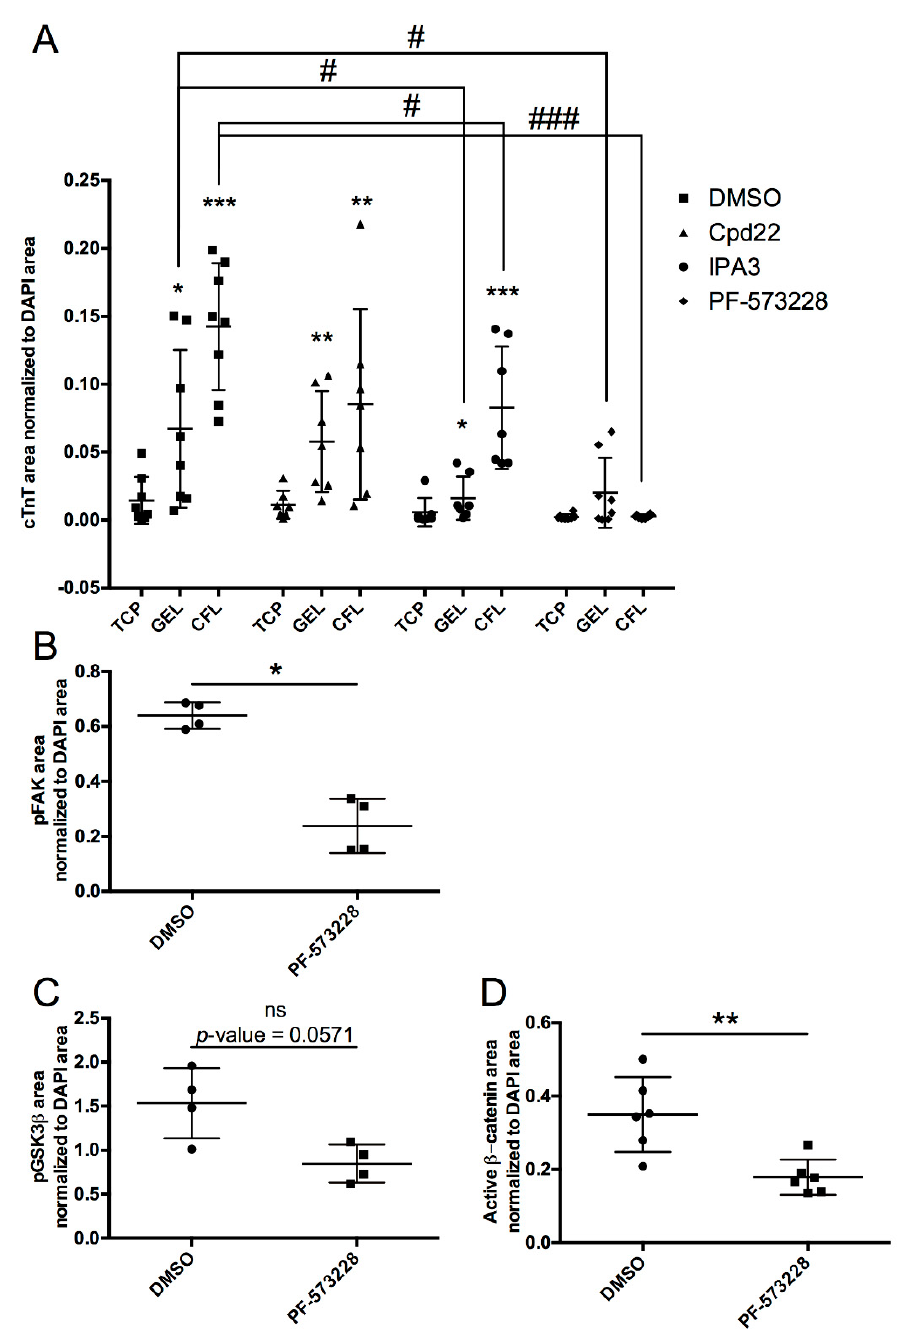
Figure 2. Differentiation of miPSCs into cardiomyocytes upon ECM engagement is secondarily associated with ILK/PAK-1 signaling and primarily associated with FAK signaling, potentially linked to Wnt signaling. ( A ) cTnT immunofluorescence staining of miPSCs after 14 days of culture in TCP, GEL, or CFL conditions with daily treatment with the control vehicle (0.1 % DMSO); ILK-specific